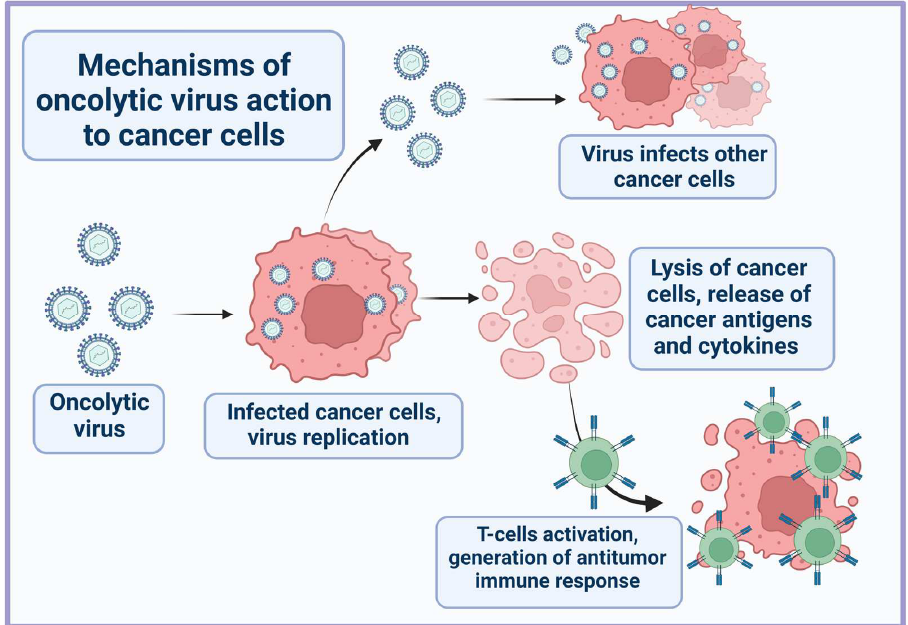
Figure 1. General scheme of oncolytic virus action on tumor cells.